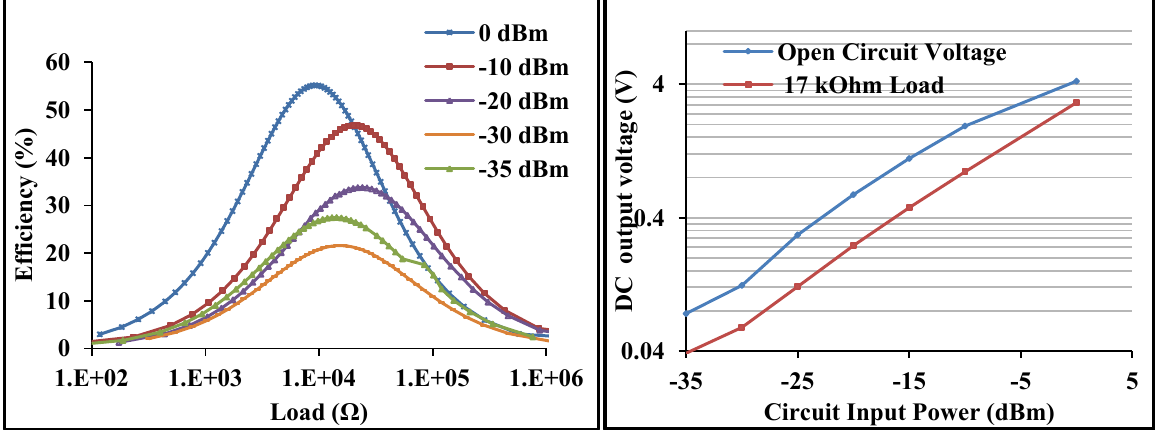
Figure 8. Measured L-matched circuit efficiency versus resistive load at various input power levels at 434 MHz ( left ), measured open circuit voltage and at 17 kΩ load versus input power at 434 MHz ( right